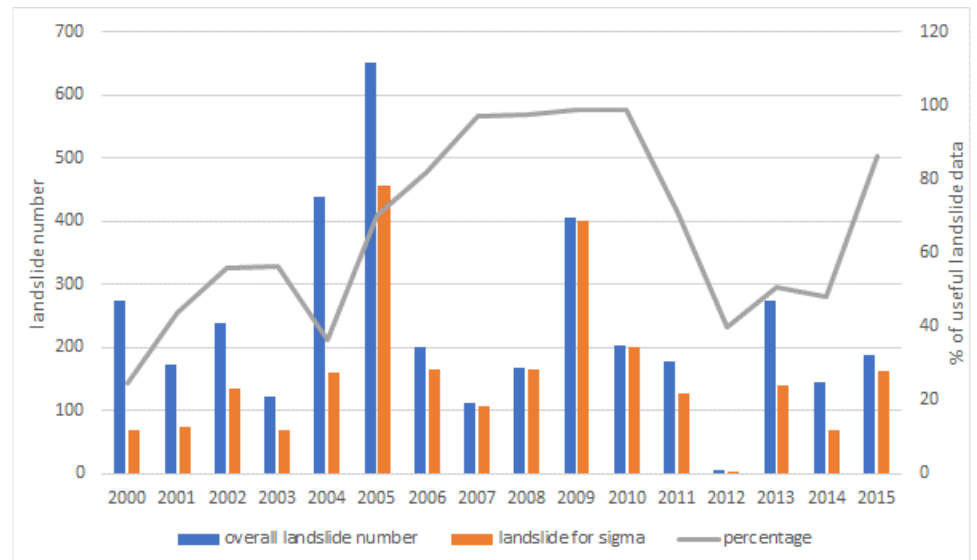
Figure 2. Collection of landslides data over the years, showing the total number of landslides collected each year and the number of landslides with good spatial and temporal accuracy that could be used for SIGMA.